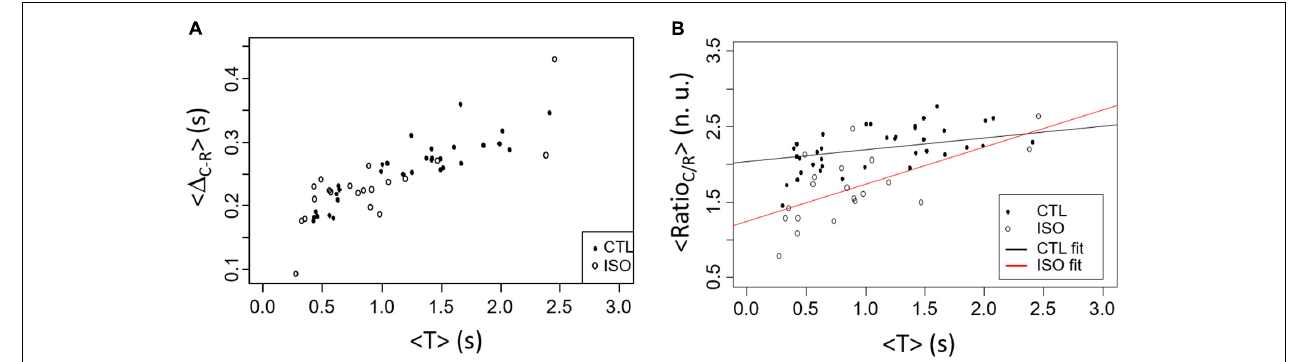
FIGURE 8 | Comparison between CTL (black points) and ISO (white circles) contraction results in spontaneous rhythm. (A) <(cid:49) R - C > as a function of < T > does not shows dissimilarity between groups. (B) < Ratio C / R > as a function of < T > differs between CTL and ISO with both a significant < T > and treatment effects (CTL vs.